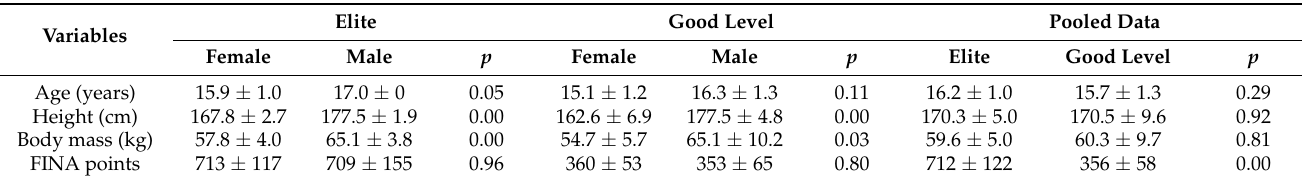
Table 1. Main physical and performance characteristics of elite and good-level swimmers (mean ±